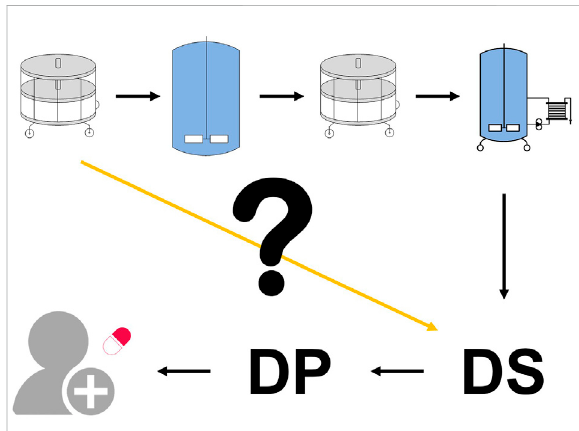
FIGURE 1 Drug substance speci fi cations de fi ne the quality limits that mustbeachieved beforeproduct release.However, theseareonly assessed at the fi nal unit operation. There is no standardized methodology for assessing the fi rst unit operation ’ s impact on the drug substance (yellow line) nor is there a standardized method for linking any derived intermediate acceptance criteria with the fi nal drug substance speci fi cations